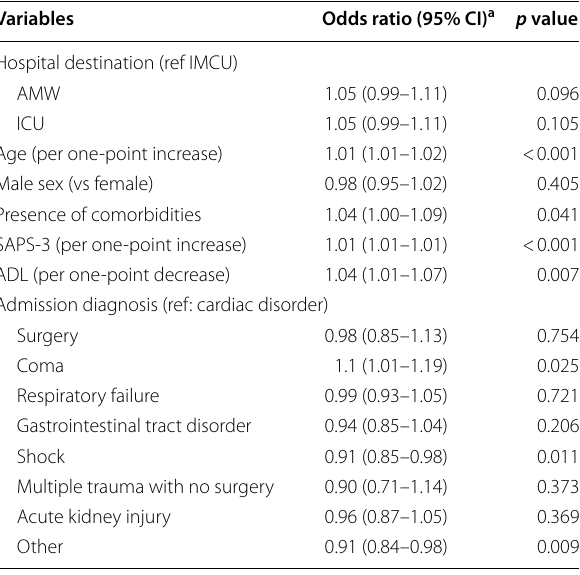
Table 3 Multivariate analysis of factors associated with mortality or loss of one-point ADL at 6